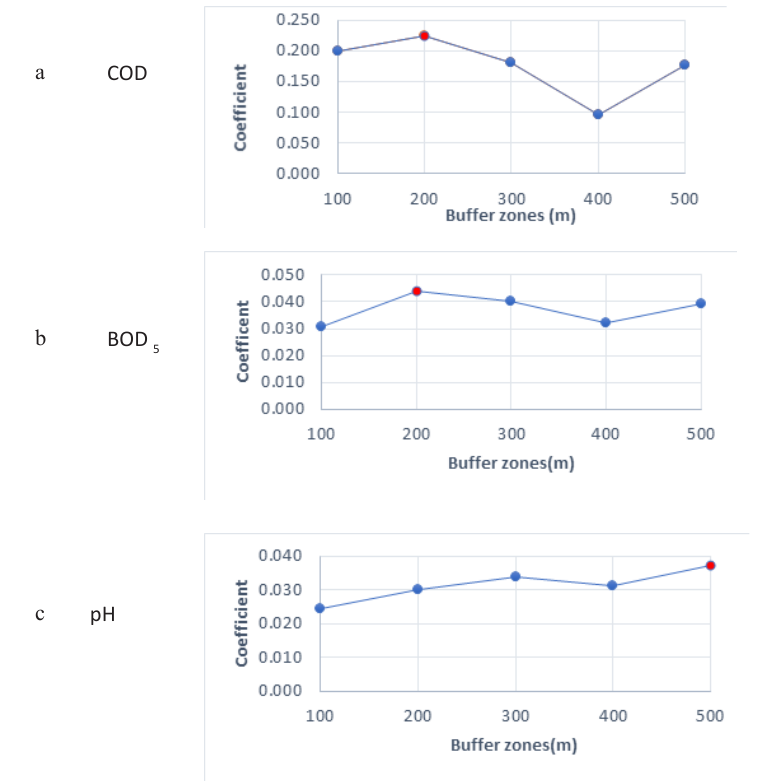
Figure 6: Regression coefficient variation for groundwater quality parameters by increment of radius of influence. Highest coefficient for COD, 0.23 (p = 0.039< 0.05) at 200 m radius and for BOD , 0.05 (p=0.003 < 0.05) at 200 m radius with built-up areas. Highest 5 coefficient for pH, 0.037 (p= 0.000 < 0.05) at 500 m radius with vegetated